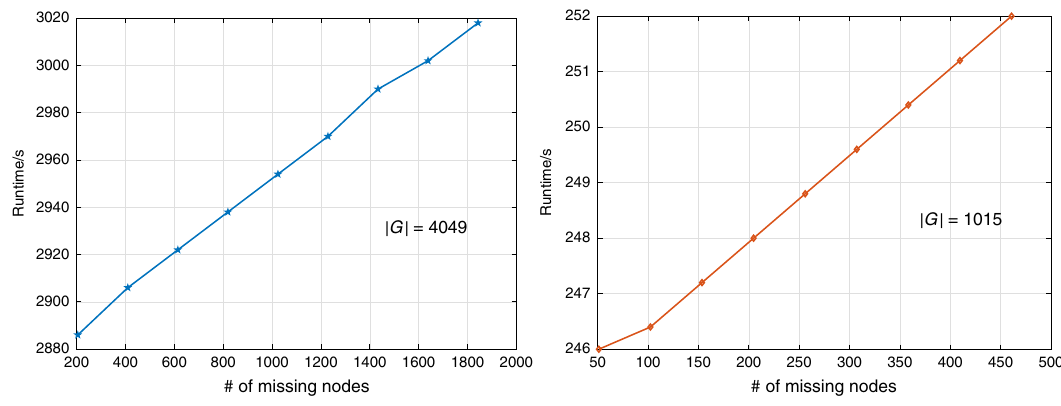
Fig. 8 Inference runtime as a function of missing nodes with a network of size 4049